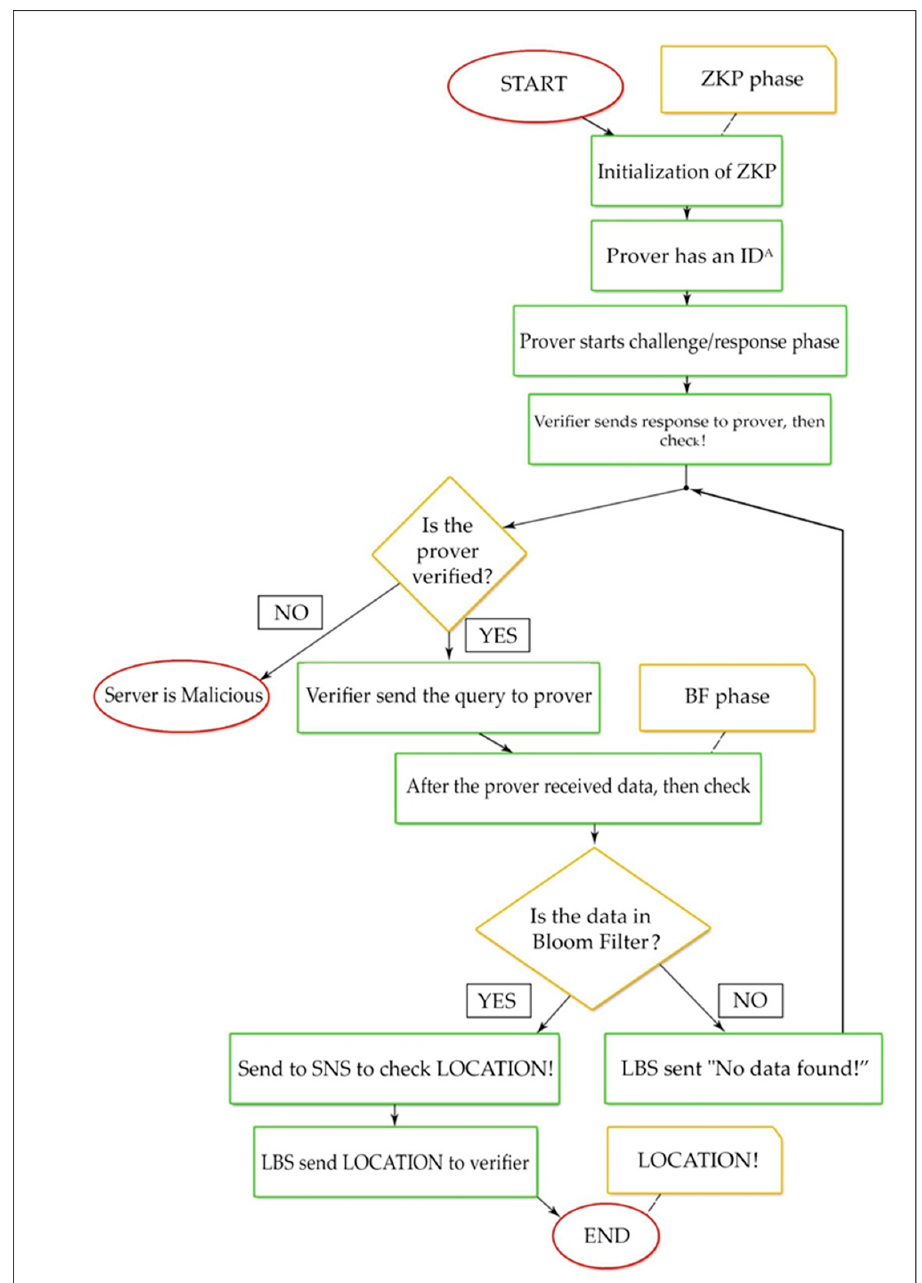
Figure 6. Flowchart of the BL0K approach.